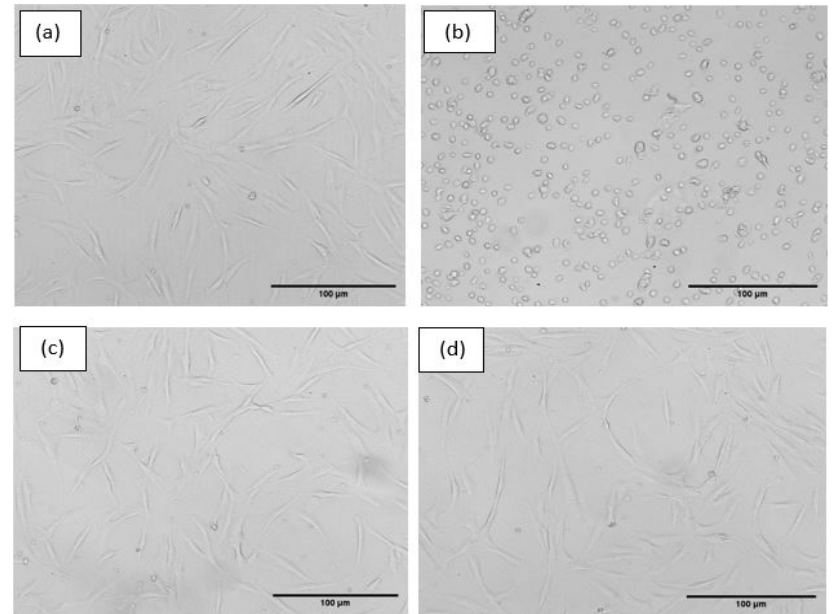
Figure 9. Inverted microscope images of hMSC Cells cultured for 72 h culture. ( a ) Untreated